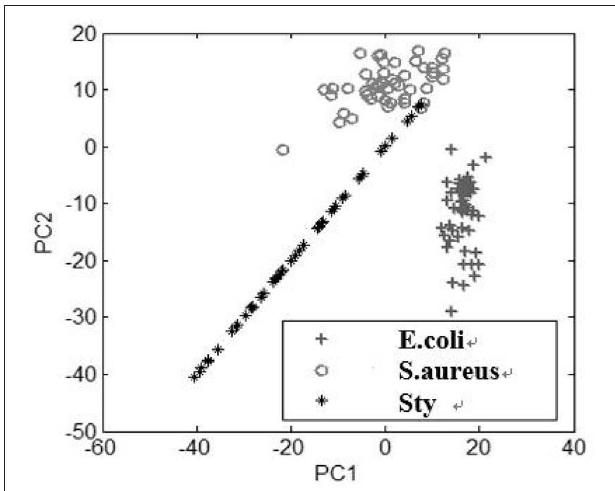
FIGURE 4 | Discrimination of the spectra of the three kinds of bacteria under acidic condition by PCA.